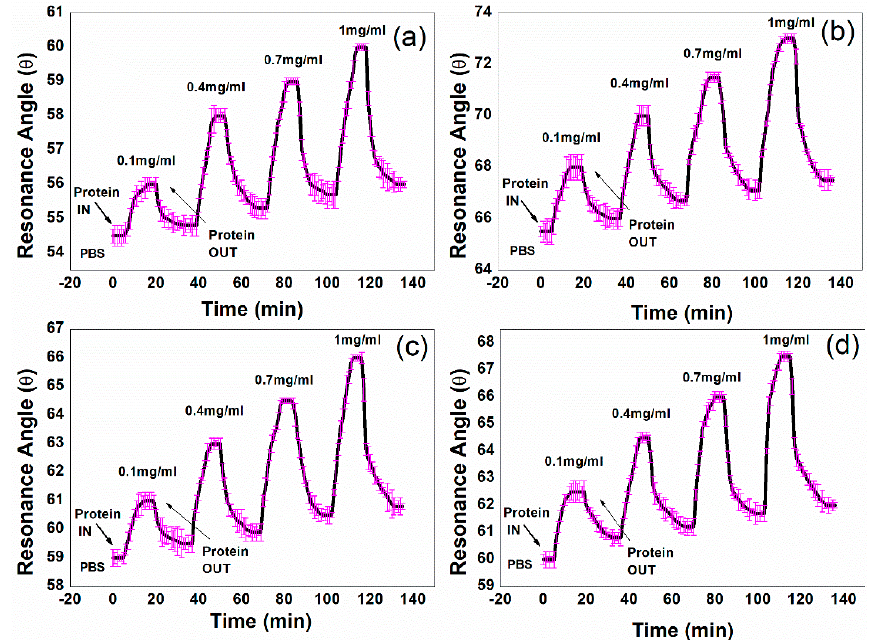
Figure 9. Sensorgrams showing the binding kinetic with protein IgG of different concentrations for sensors: ( a ) Ag-I, ( b ) Au-II, ( c ) Ag-Au-III, ( d ) Ag-Au-IV.